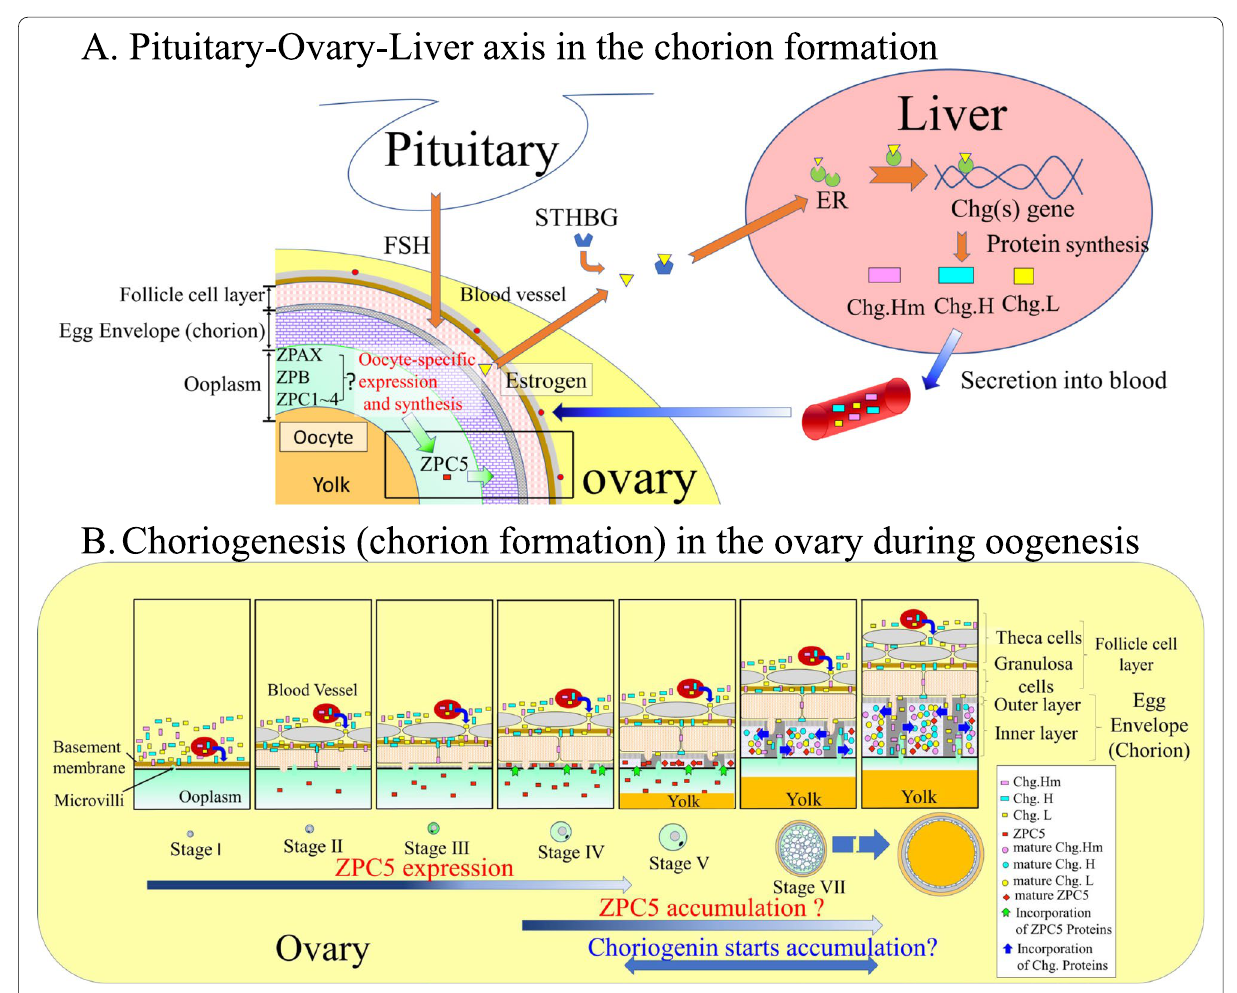
Fig. 9 Summary of chorion formation in medakas. Choriogenin (Chg.) expression is induced by estrogen in the liver. Chgs. are secreted into the blood (A: gradient blue arrows) and transferred to the ovary (A), where they accumulate in the chorion by way of the pore canals (B: solid dark blue arrows) after modification. Oocyte-expressed ZPC5 (A) and possibly other ZPs pass through the oocyte plasma membrane (B: green arrows) and accumulate in the chorion. It is still unknown if ZPC5 accumulates in the chorion through the pore